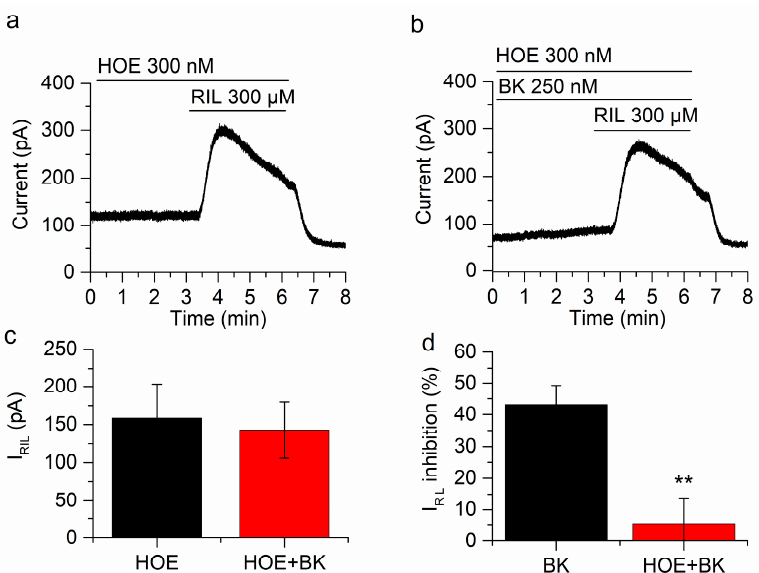
Figure 4. BK inhibition of I RIL is mediated by B 2 R. ( a ) I RIL was not a ff ected in the presence of HOE-140 ( d -Arg-[Hyp3, Thi5, d-Tic7, Oic8]BK) in mSCG neurons held at − 30 mV. ( b ) In the presence of HOE-140 the inhibition of I RIL by BK was significantly reduced. ( c ) There is no di ff erence between I RIL control (158.3 ± 44.9 pA, black bar) and I RIL in the presence of BK and HOE-140 (142.7 ± 36.8 pA). ( d ) The inhibition by BK in the presence of HOE-104 was 5.2 ± 8.3% (red bar), which is significantly di ff erent from the inhibition in the absence of HOE-140 (43.2 ± 6.1%, black bar, p < 0.01). Recordings in ( a , b ) belong to the same neuron. ** p < 0.01.